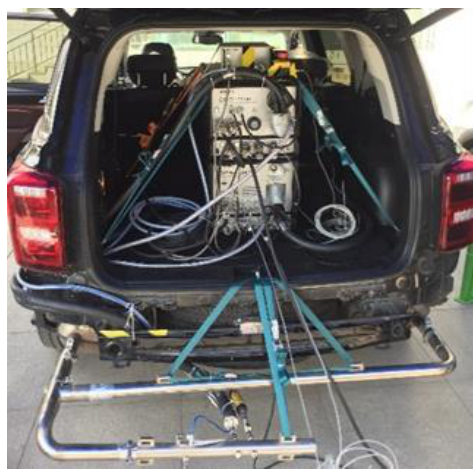
Figure 2. PEMS equipment installation diagram. Table 3. Experimental conditions.